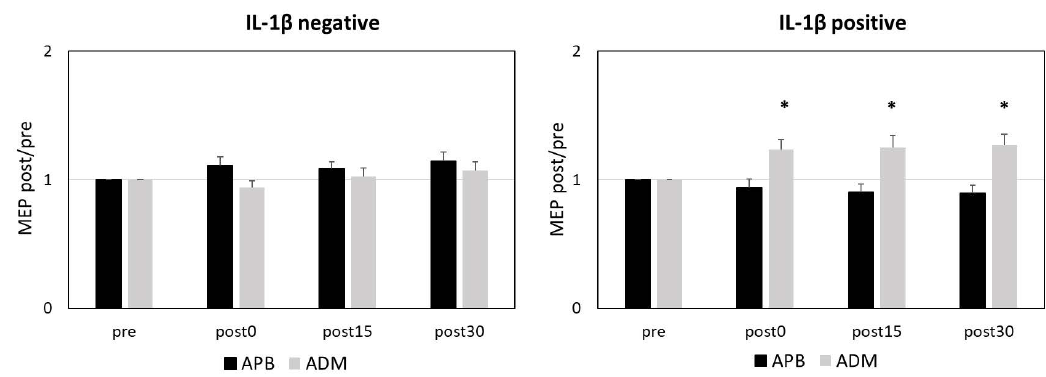
Figure 3. IL-1 β CSF Detectability and PAS Effects. Figure 3 legend. In the IL-1 β negative group, PAS failed to induce LTP-like effects in both APB and ADM muscles ( left panel ), whereas in the IL-1 β positive group, PAS elicited an abnormal LTP in the ADM muscle ( right panel ). * p ≤ 0.05. The p values refer to the comparisons between pre and post 0, post 15, and post 30 in each muscle. All p values were adjusted by Benjamini–Hochberg correction. Abbreviations: APB (abductor pollicis brevis); ADM (abductor digiti minimi); CSF (cerebrospinal fluid); IL (interleukin); PAS (paired associative stimulation).